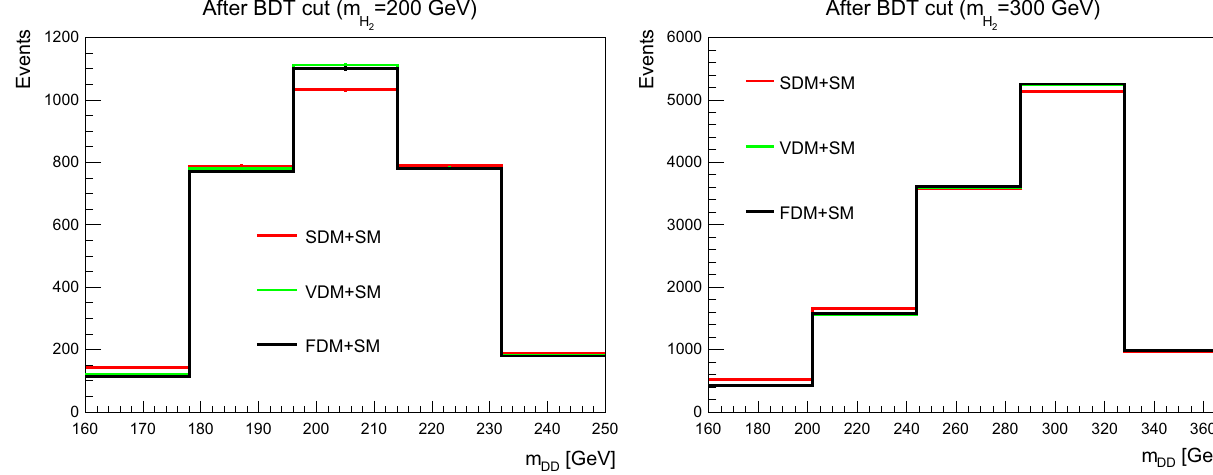
Fig. 7 Distributions of m DD after the BDT cut for each signal plus background. Left: discriminating the spin of the benchmark point FDM200. Right: discriminating the spin of the benchmark point